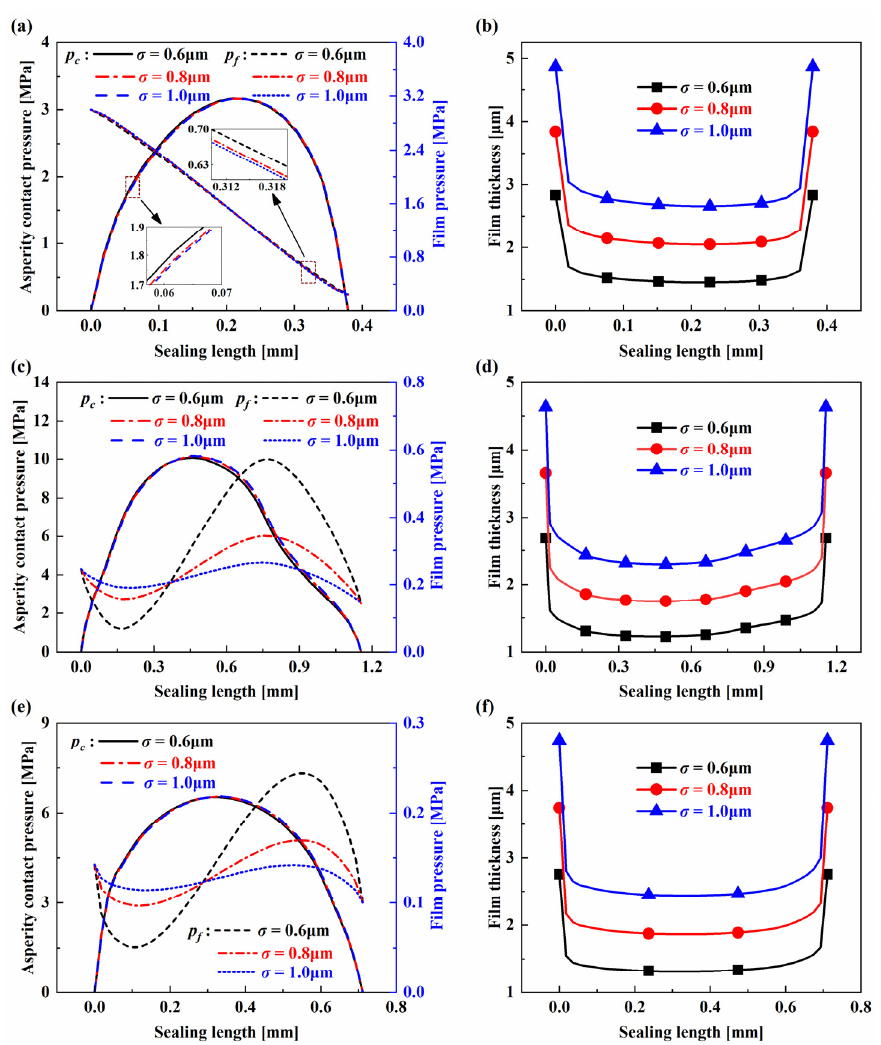
Figure 8. Pressure and film thickness distributions with different surface roughness: ( a , c , e ) pressure of the left lip, main lip, and right lip; ( b , d , f ) film thickness of the left lip, main lip, and right lip.